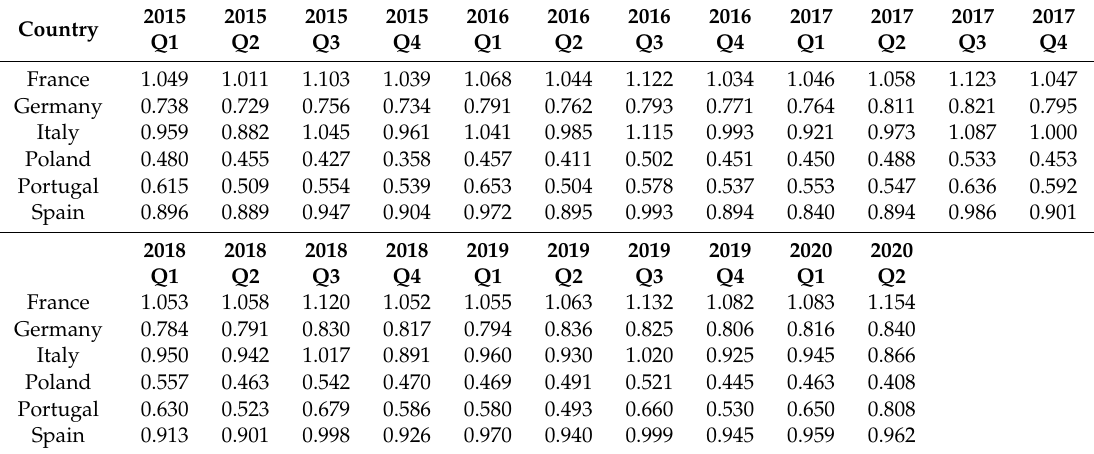
Table 4. Investment multipliers, own work, source: